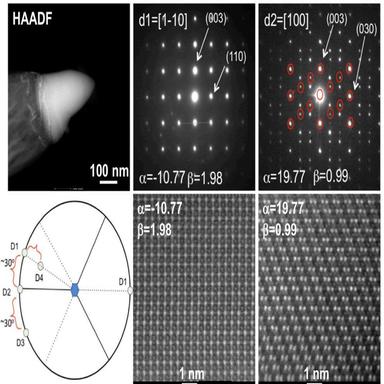
Top: image (HAADF) and SAD analysis of one of the AlFeTh particles. Bottom: diagram showing the angular relationship of the crystal and examples of atomic level HAADF S/TEM images along low index zone axes.